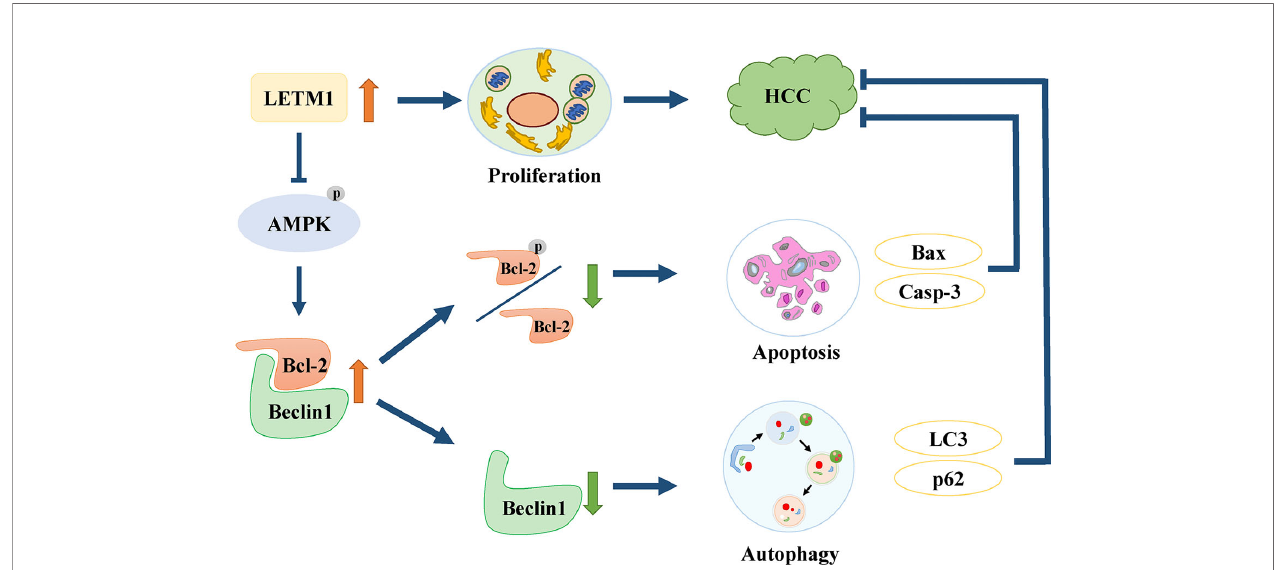
FIGURE 7 | Schematic of oncogenic role of LETM1 in hepatocellular carcinoma (HCC). LETM1 promotes HCC progression through enhancing cell proliferation and suppressing autophagy and cell apoptosis via inhibiting AMPK activation mediated-Beclin-1/Bcl-2 complex